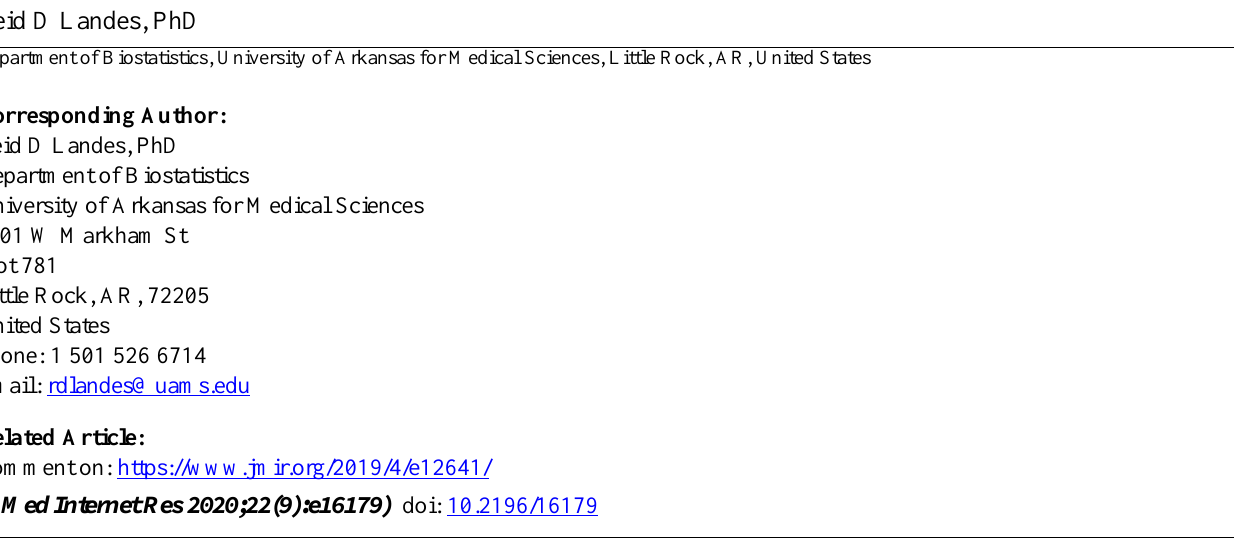
• Figure 4c caption: “(ie, number of samples per treatment , with sampling rate fixed at 1 sample per time unit)” • Figure 4a and 4b: the label for the horizontal axis should be “Number of samples per treatment ” • Page 8: “In Figure 4a, we see that for effect sizes of 0.1, 0.2, and 0.3, more than 100 samples per treatment are needed to obtain a power of 0.8 (at a standard 5% significance level). For an effect size of 0.4, at least 100 samples per treatment are needed. For effect sizes of